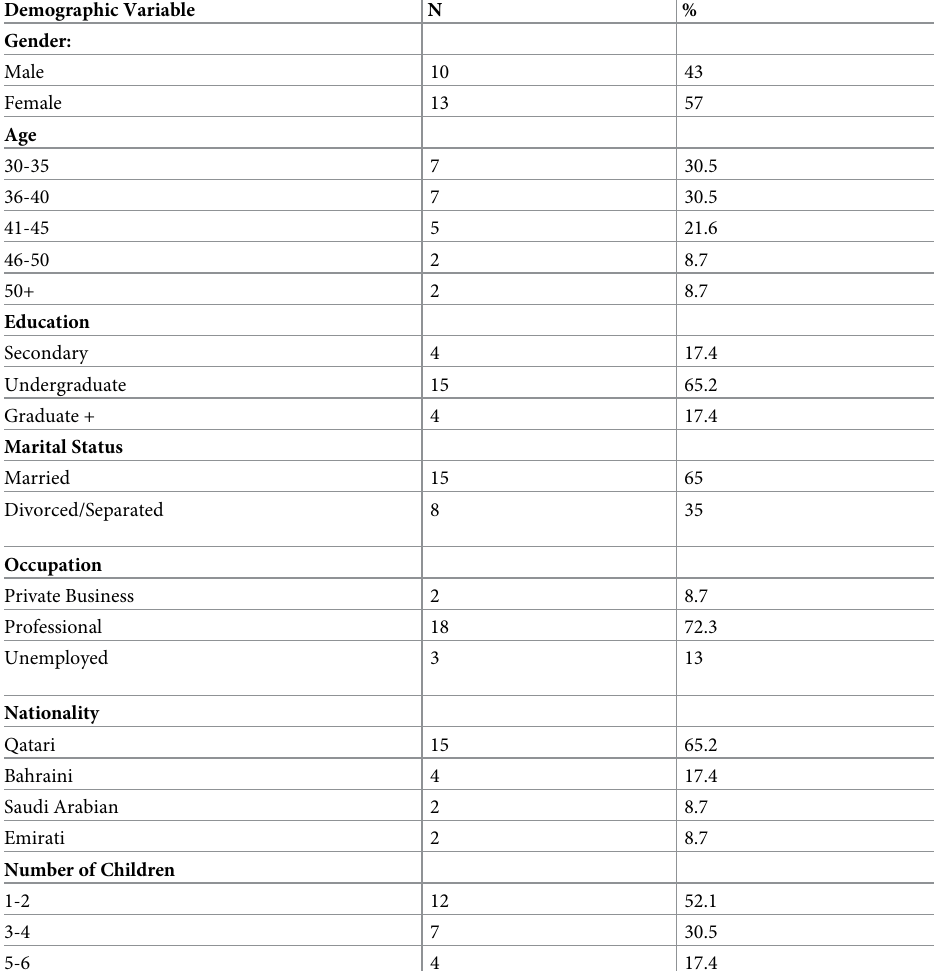
Table 8. Sociodemographic information for the interview sample. Gender, age, education, marital status, occupa- tion, nationality, and number of children by number and percentage of